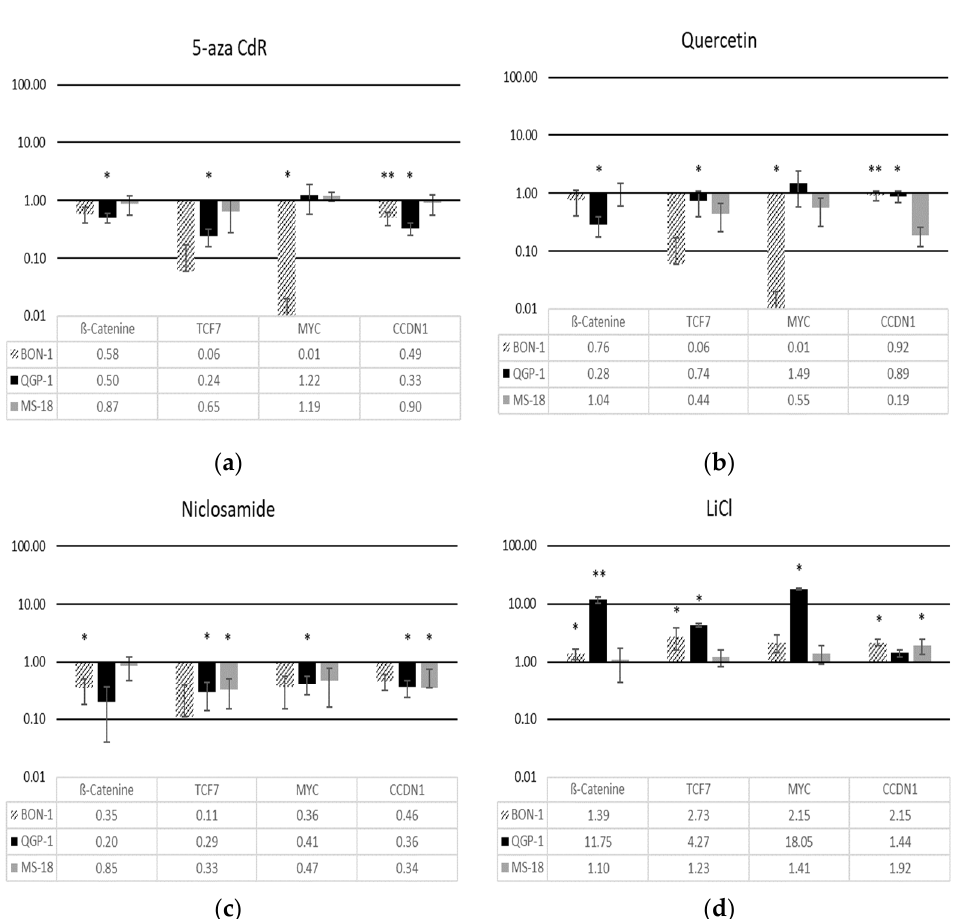
Figure 1. mRNA expression of ß-Catenin, TCF7, MYC, and CCDN1 (Cyclin D1) after treatment with ( a ) 5-aza CdR; ( b ) quercetin; ( c ) niclosamide; and ( d ) LiCl in BON-1, QGP-1, and MS-18 cells (logarithmic scale). The data are shown as percentages of untreated control cells. The expression levels were normalized to housekeeping gene GAPDH ( mean ± SD; n = 6 experimental repeats; * p < 0.05, ** p <